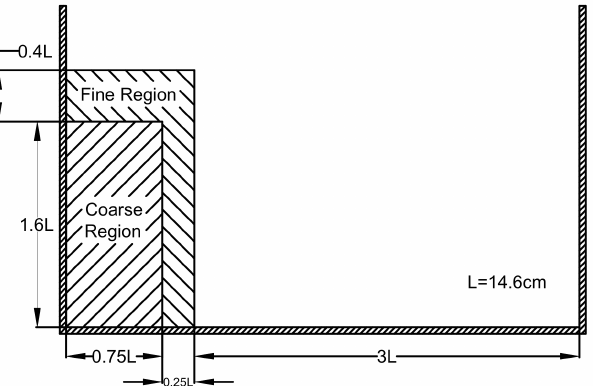
Figure 7. Configuration of the coarse and fine regions in computational domain of the dam-break